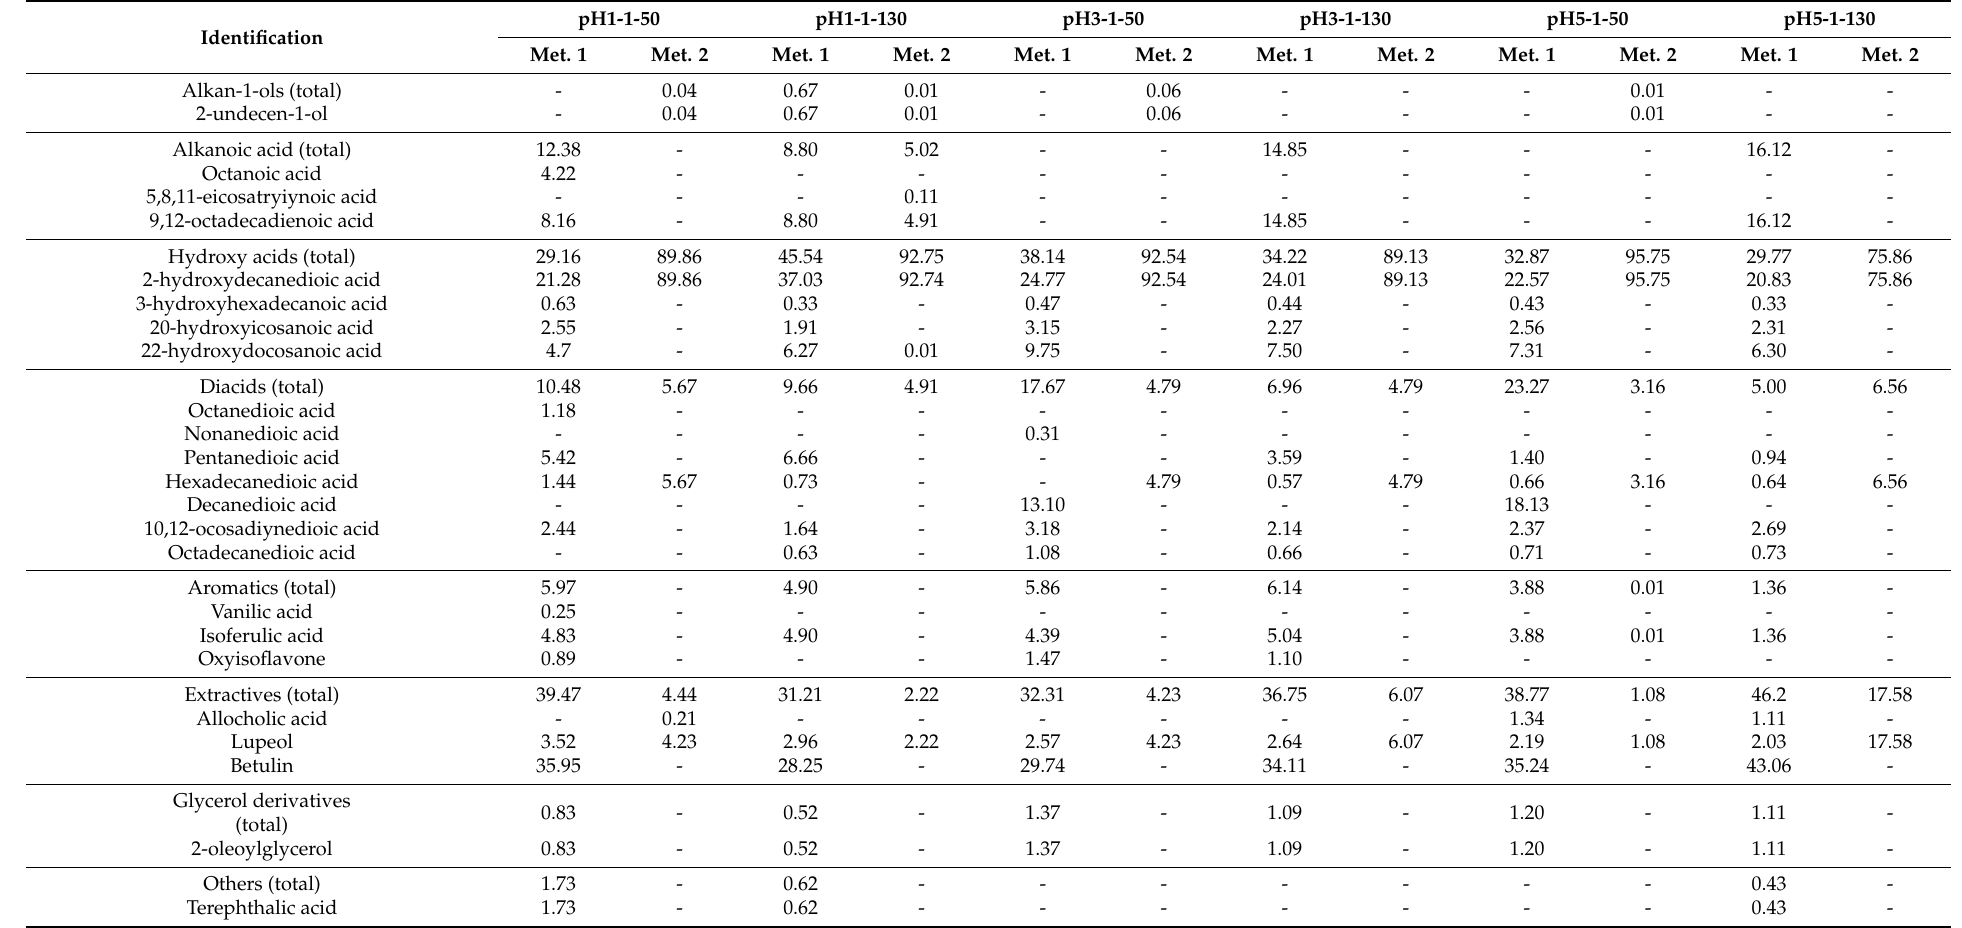
Table 3. Main monomers identified by GC-MS analysis of SA samples, before and after hydrolysis (area, rel% from